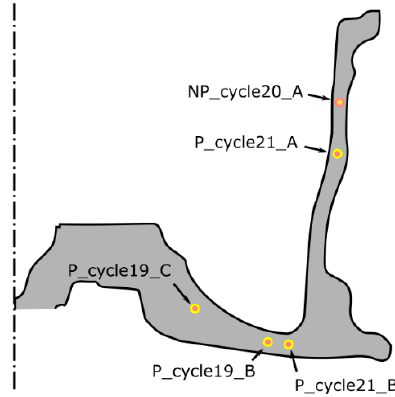
Figure 15. Cast-in TC locations in wheels produced with Die-A.